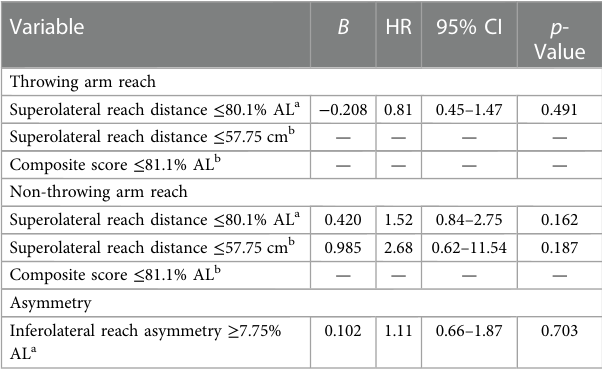
TABLE 2 Results of the Cox proportional hazard survival regression for sport-related injuries of the whole body by throwing